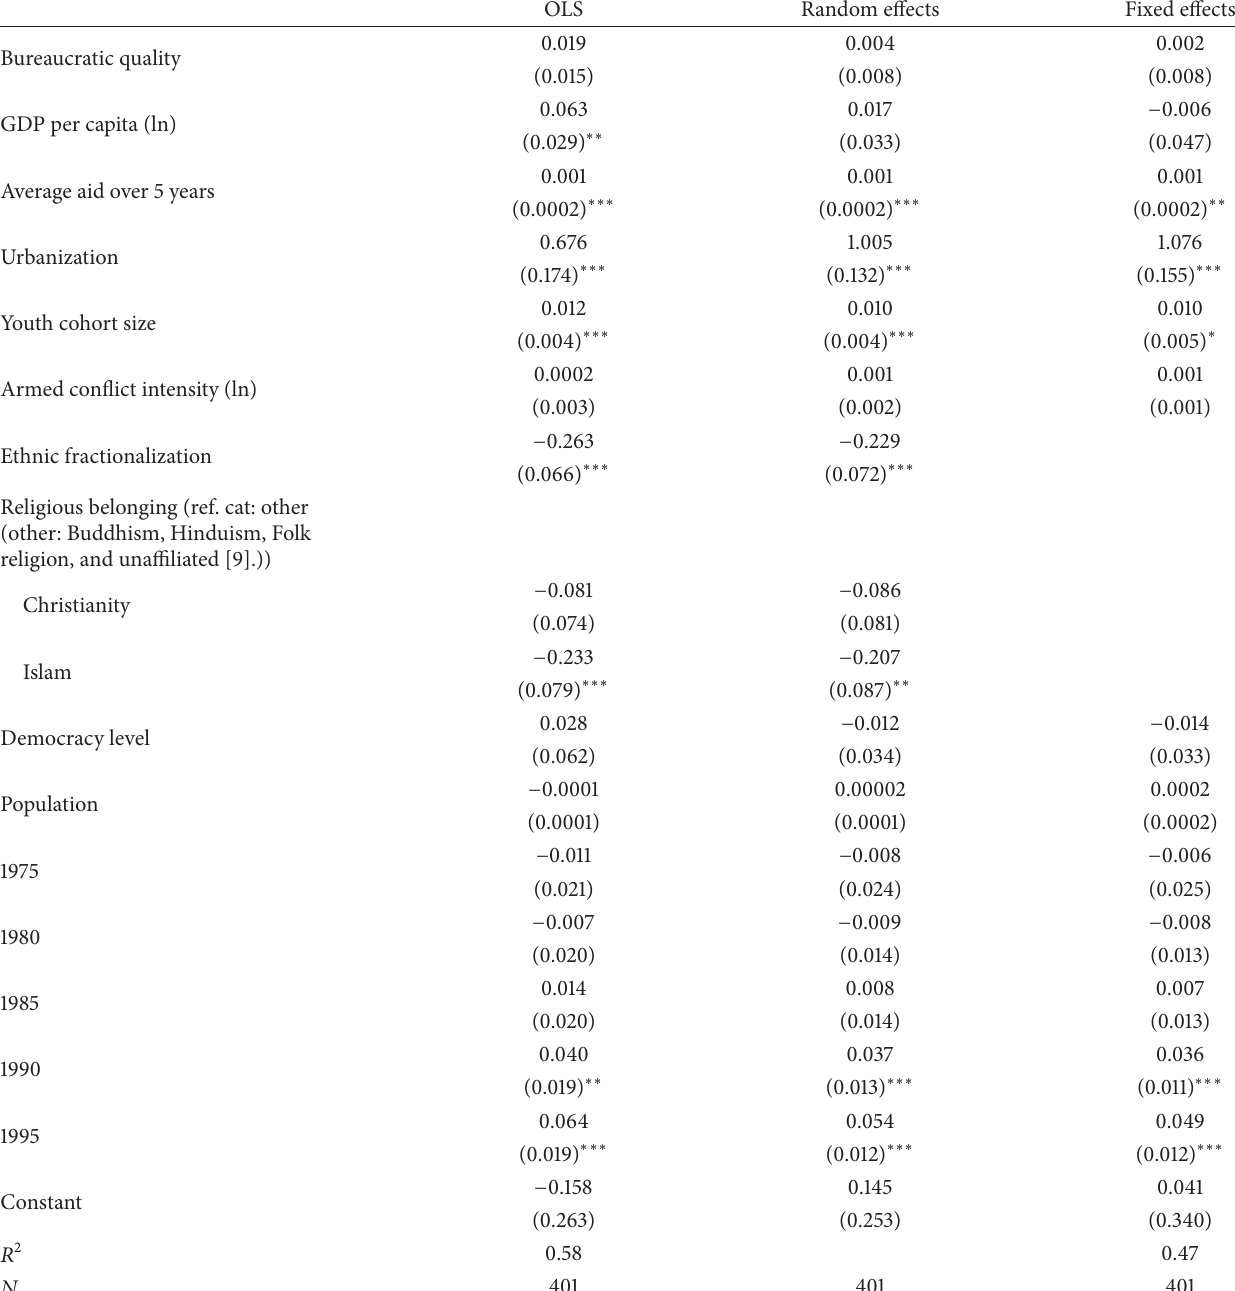
Table 2: Gender parity in secondary education attainment, developing countries: 1970–2010. Alternative measure of religion: